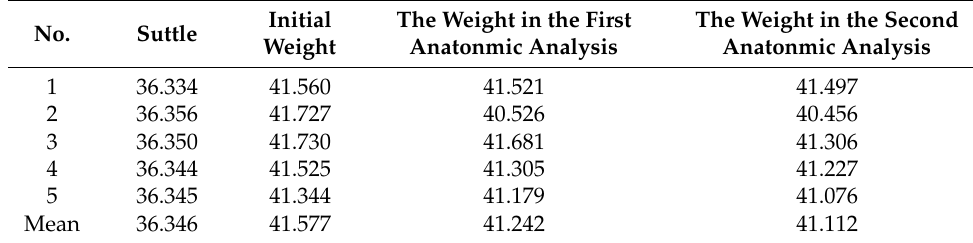
Table 2. Change in weight of bearing lubricant system.